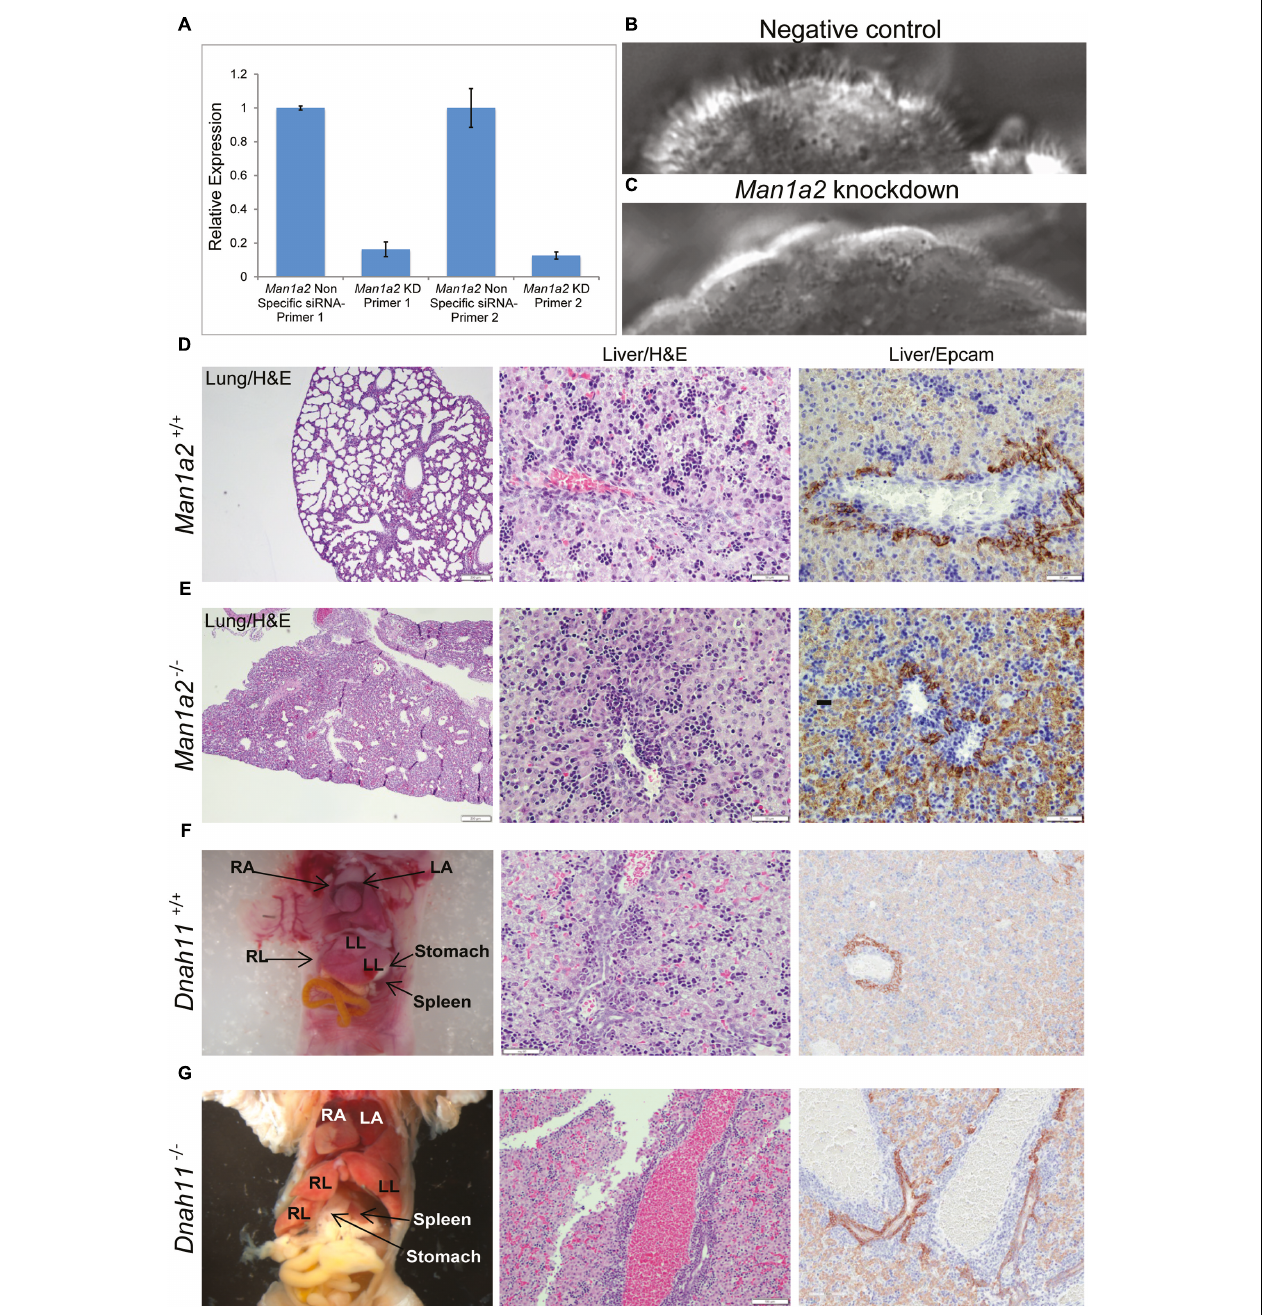
FIGURE 5 | Man1a2 knockdown produces cilia defects in reciliating mouse respiratory epithelia. (A) Relative expression of Man1a2 in respiratory epithelia after siRNA transfection. (B) Control epithelia are well ciliated with well-coordinated ciliary beat with a full stroke ( Supplementary Video 1 ). (C) Man1a2 -siRNA-transfected respiratory epithelia exhibited very short cilia that were mostly immotile except for a few areas with slow dyskinetic ciliary beat with incomplete stroke ( Supplementary Video 2 ). (D,E) Man1a2 knockout mice with lung involvement also exhibit liver inflammation. (D) Man1a2 + / + liver shows a portal area with indistinct bile ducts, abundant extramedullary hematopoiesis (EMH, H&E x200), and minimal ductular reaction (Epcam x200). The lung shows expanded alveoli and thin interalveolar septa. (E) Man1a2 − / − liver shows expanded portal areas with inflammation including EMH (H&E) and ductular reaction (Epcam x 200). The lung shows thick septa with sparse, unexpanded alveoli. The Man1a2 − / − liver transcriptome shows several dysregulated ciliary genes, including Dnah11 which causes PCD ( Table 2 and Supplementary Table 10 ). (F,G) . Dnah11 − / − mice with situs inversus also exhibit biliary inflammation. (F) Dnah11 + / + mouse with normal location of heart and abdominal organs which includes two left and one right liver lobes, normal liver histology with EMH and some bile ducts in portal area. (G) Dnah11 − / − null mouse shows situs inversus with cardiac heterotaxy, inverted lobation of the liver (two right lobes), right-sided stomach and more centrally located spleen. Liver shows portal congestion and bile duct proliferation. All experiments were performed in triplicate.